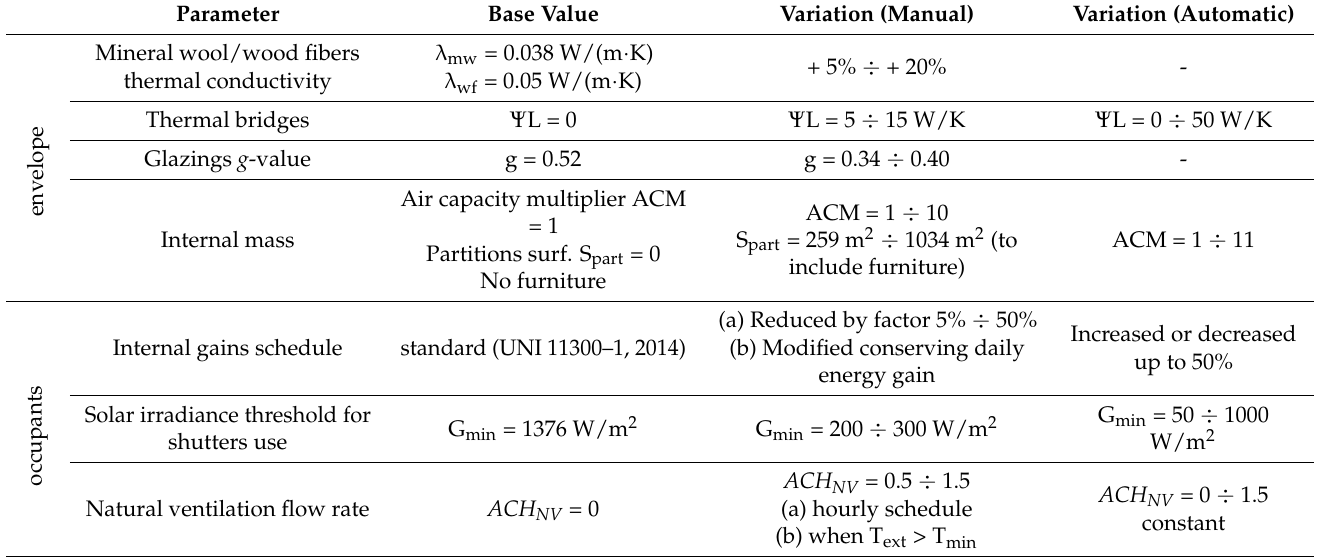
Table 3. Parameters of the sensitivity analysis performed in the manual calibration approach (base values and range), and range of variation of the parameters in the automatic calibration